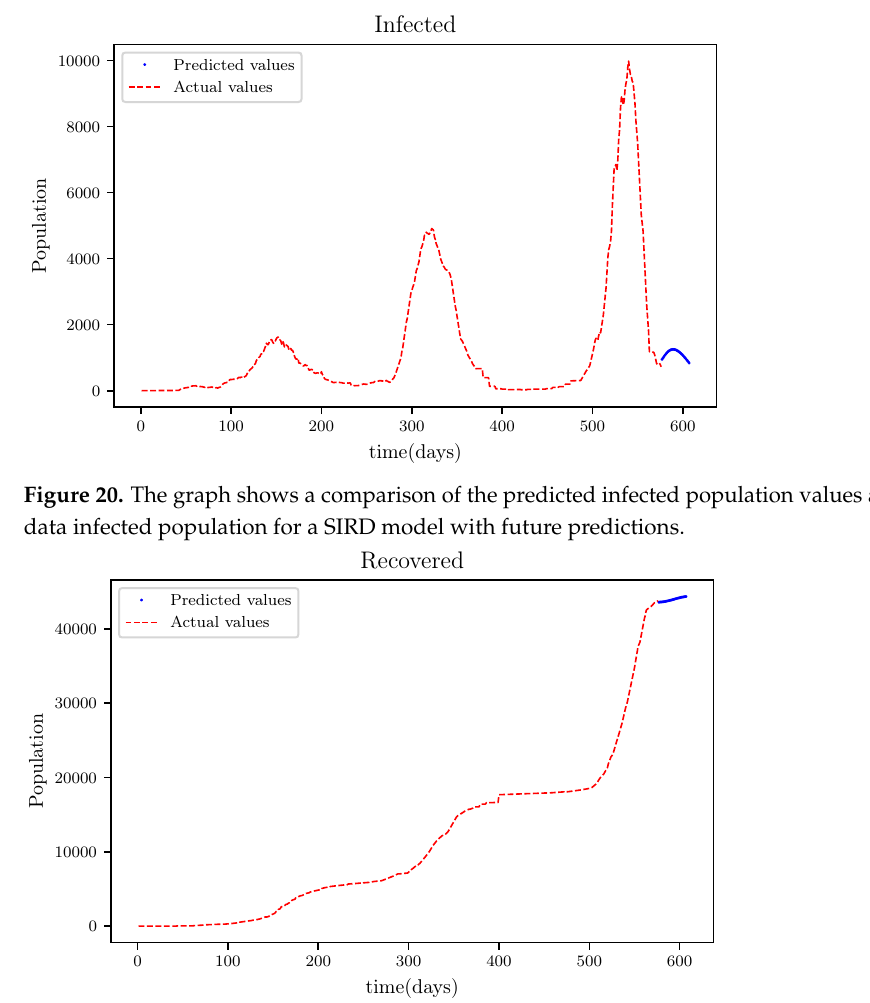
Figure 21. This graph shows a comparison of the predicted values of recovered population and the actual data of recovered population for a SIRD model with future predictions.